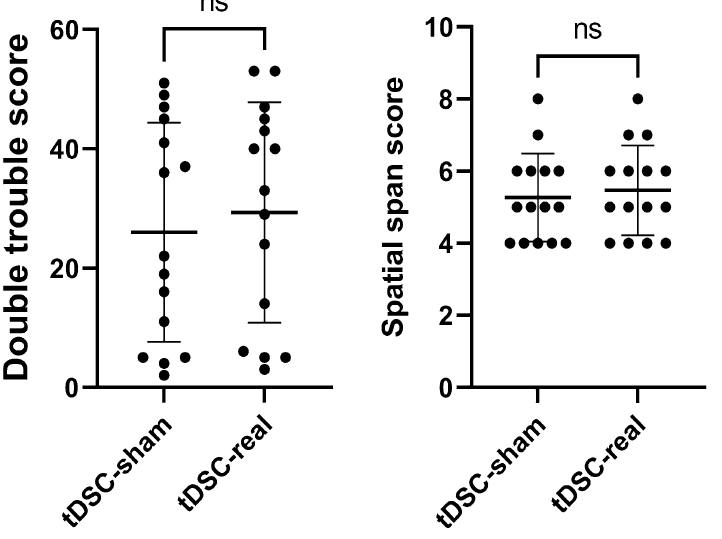
Figure 3. Dot plots representing the participants’ performance for the cognitive behavioral assessment.